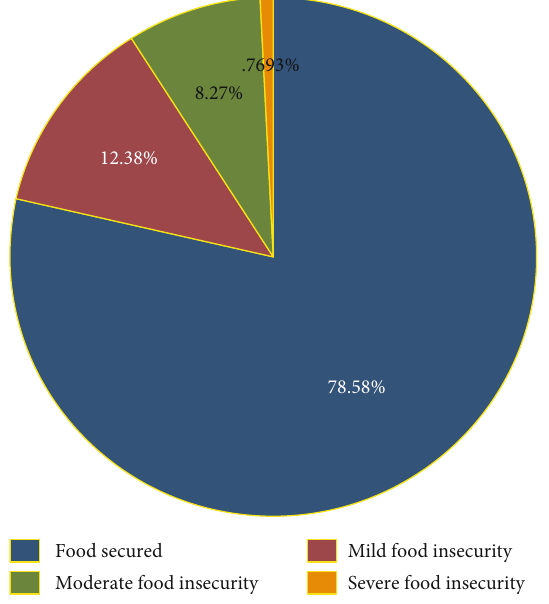
Figure 1: Magnitude of child food insecurity in Dabat HDSS, North West Ethiopia: April 2019.